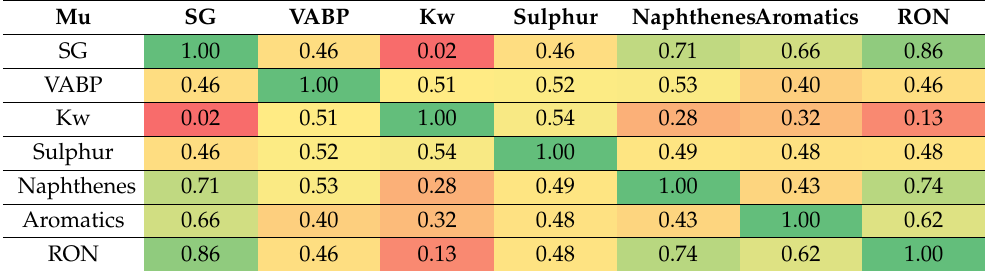
Table 8. µ -values of the Intercriteria analysis evaluation of relations between properties of naphtha fractions derived from 244 different crude oils.